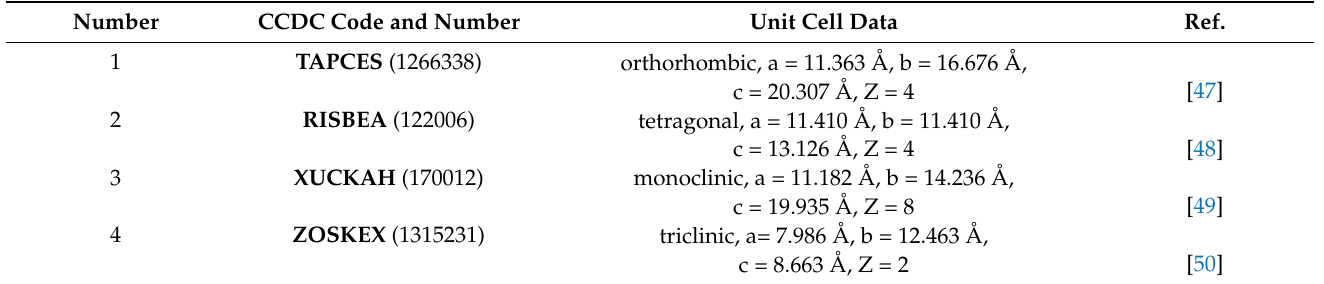
Table 3. Cambridge Crystallographic Data Centre (CCDC) code, number, and experimental unit cell data for the investigated “proton